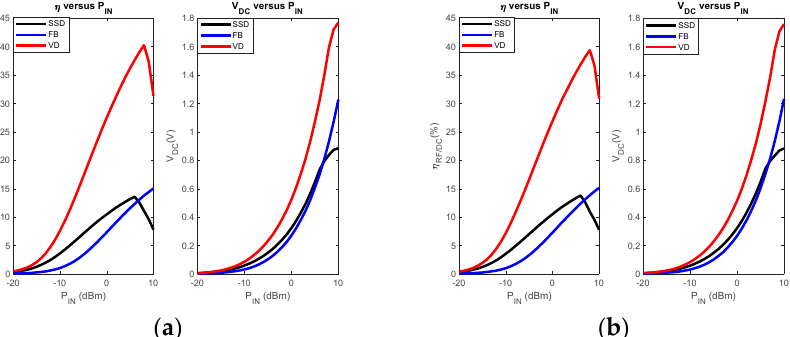
Figure 11. Performance comparison of main commonly used rectifier topologies. ( a ) 900 MHz GSM band. ( b ). 2.45 GHz ISM band.